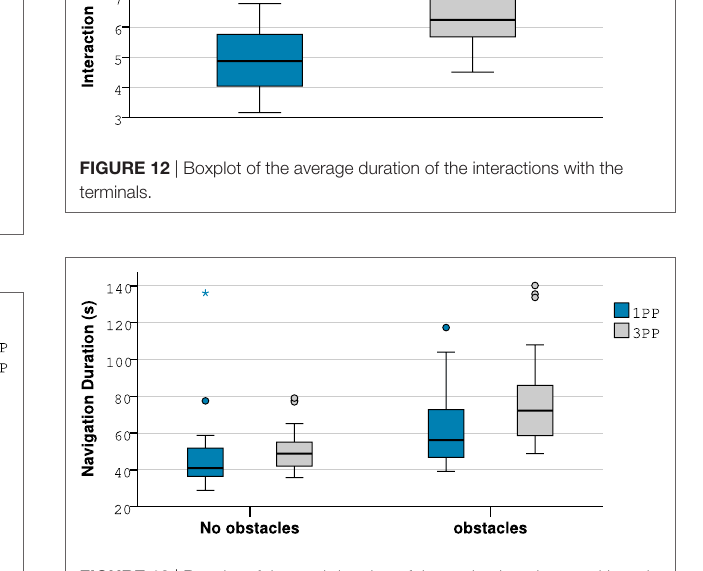
FigUre 10 | Boxplot of the average perception delay of the projectiles.